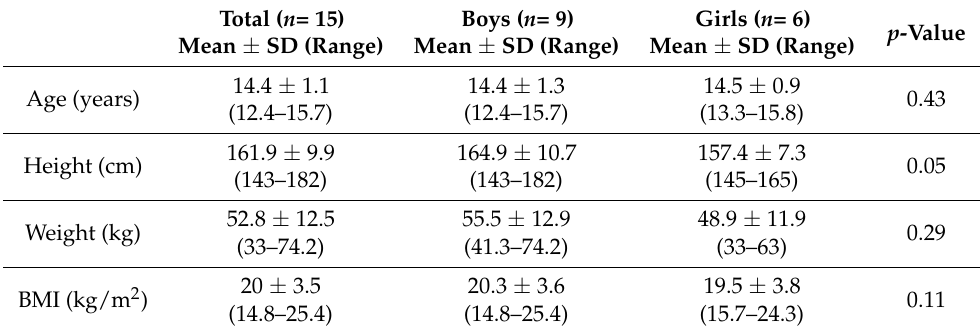
Table 1. Demographic and anthropometric characteristics of the study population ( n = 15).